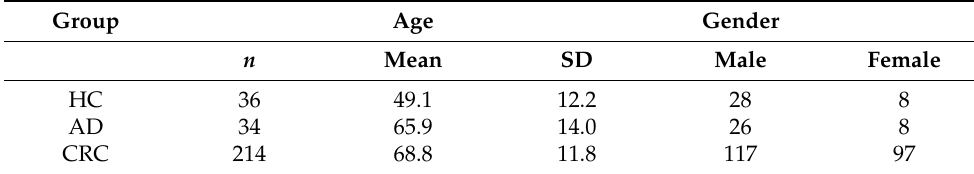
Table 1. Subjects’ characteristics.